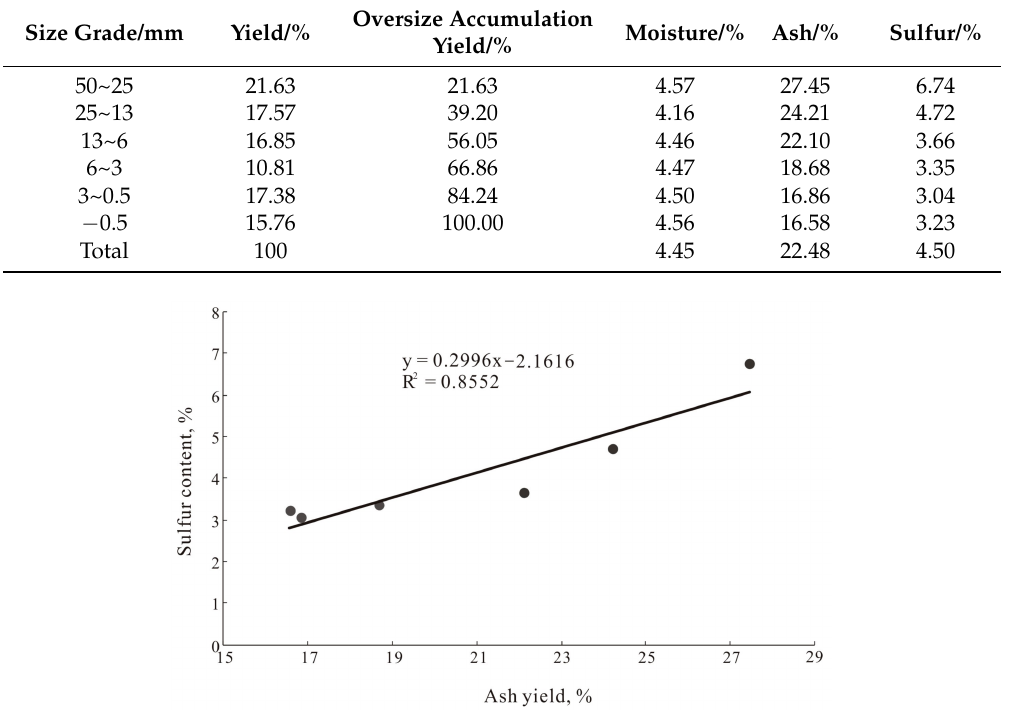
Figure 2. The relation between ash yield and sulfur content among different size